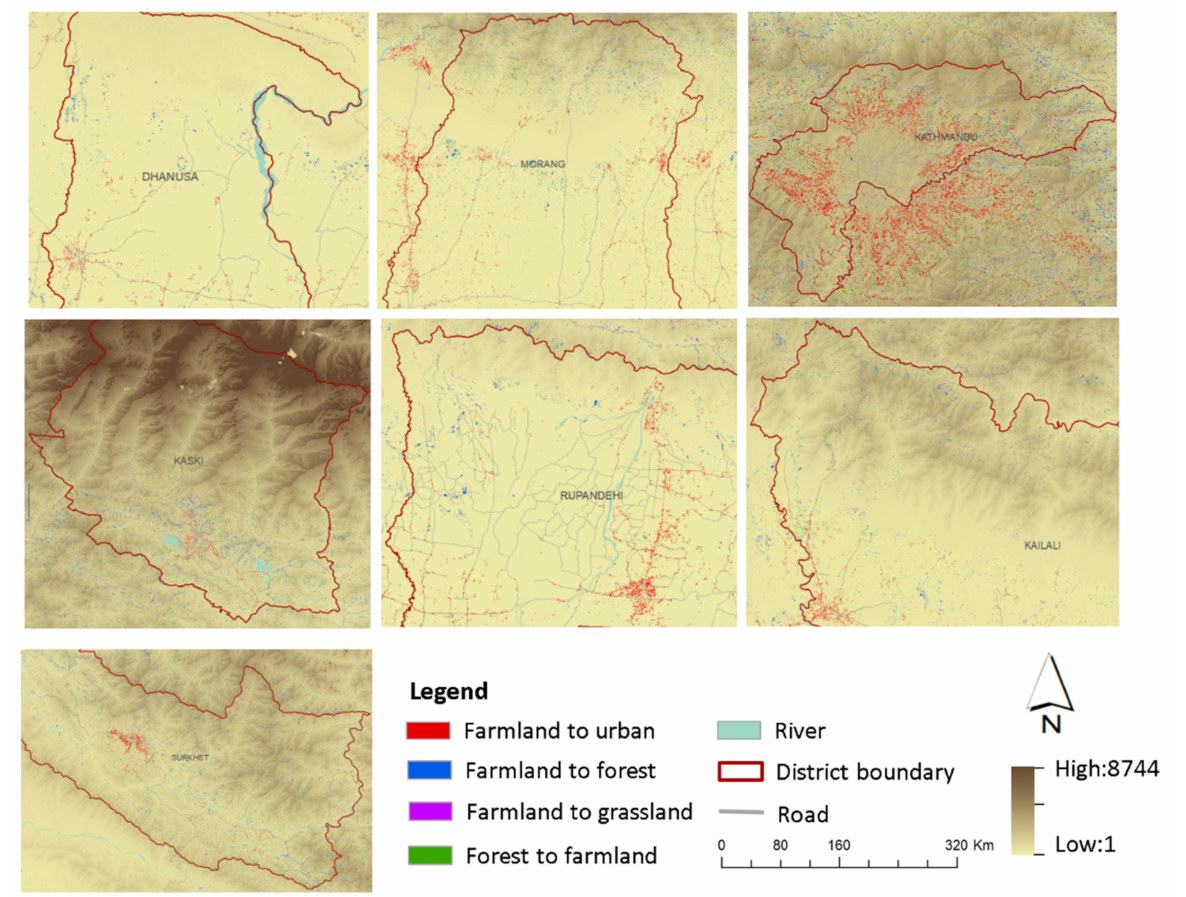
Figure 7. Spatial distribution of four kinds of land cover changes from 2016 to 2019. Maps of river, road and topography are overlaid on it. The Terai districts are Morang, Dhanusa, Kailali and Rupandehi. The Hill districts are Surkhet and